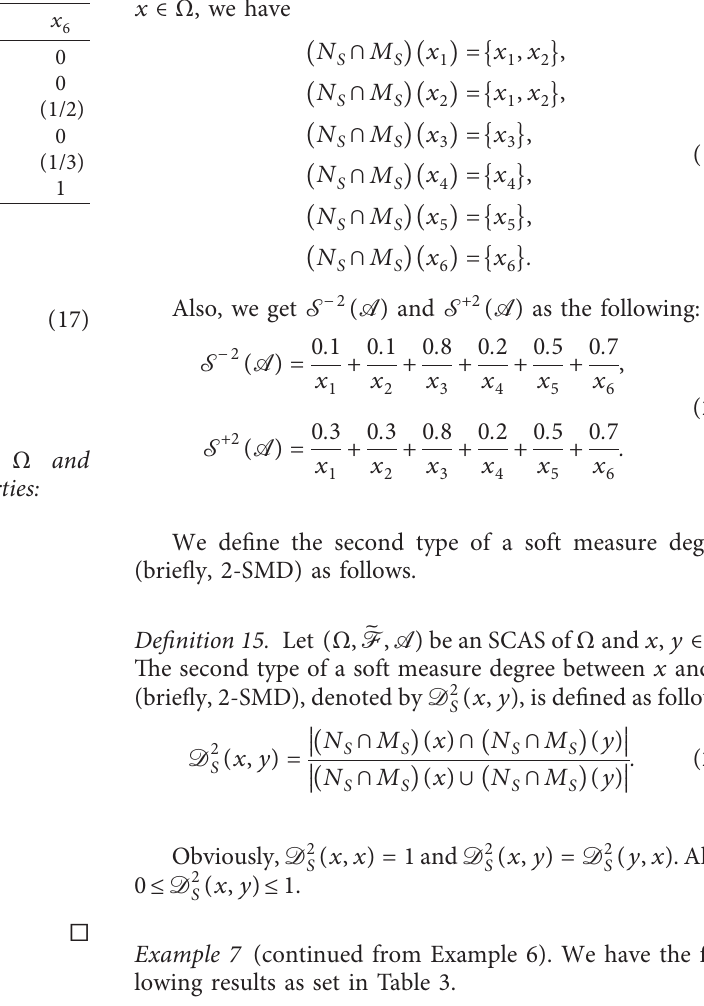
( x ,x ) ∀ i, j ∈ 1 , 2 , ... , 6 { } i j S